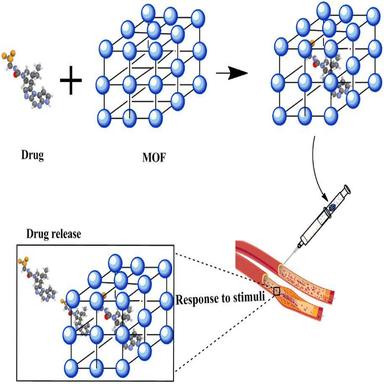
The schematic representing the drug delivery system.